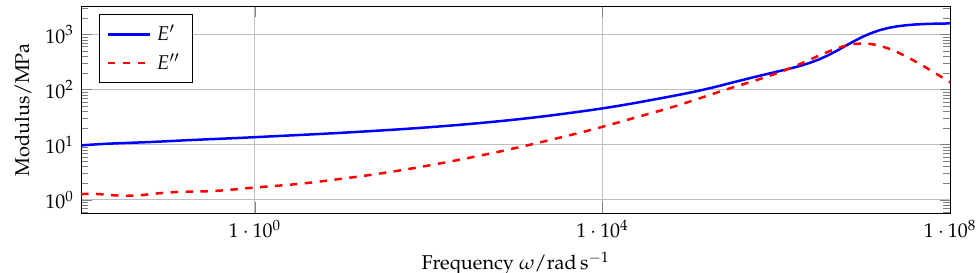
Figure 9. Storage module E (cid:48) and loss module E (cid:48)(cid:48) for a rubber material as a function of frequency ω (material m1 from ([31], [Appendix